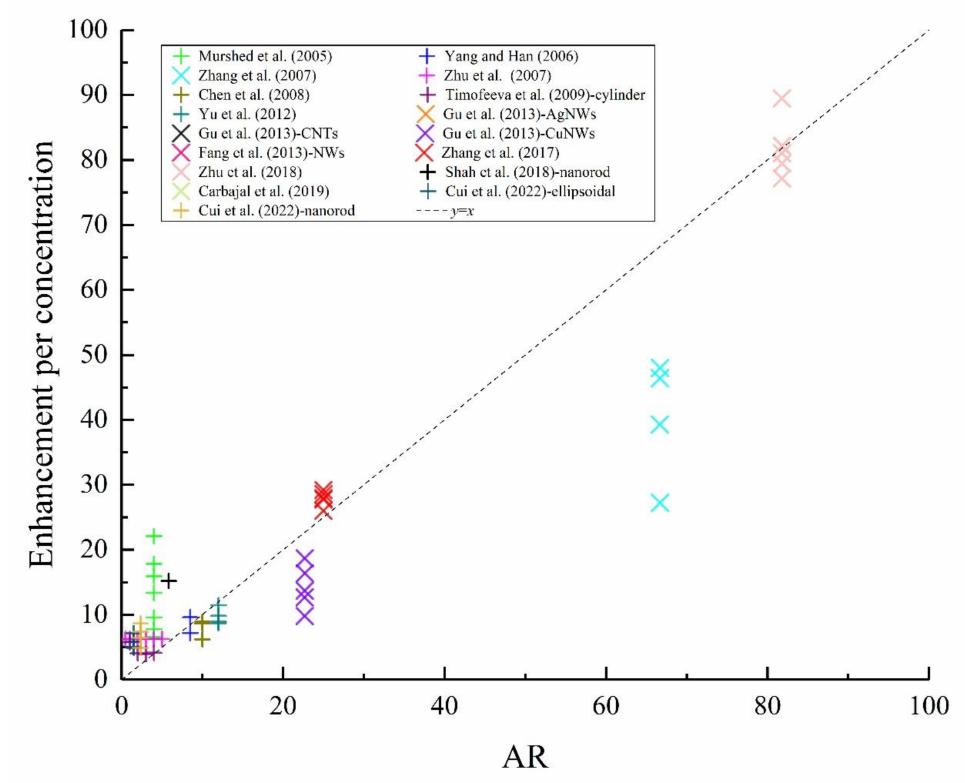
Figure 3. Enhancement per concentration as a function of aspect ratio at room tempera- ture [2,3,10,15,24,27–29,31,33–35,47,50].